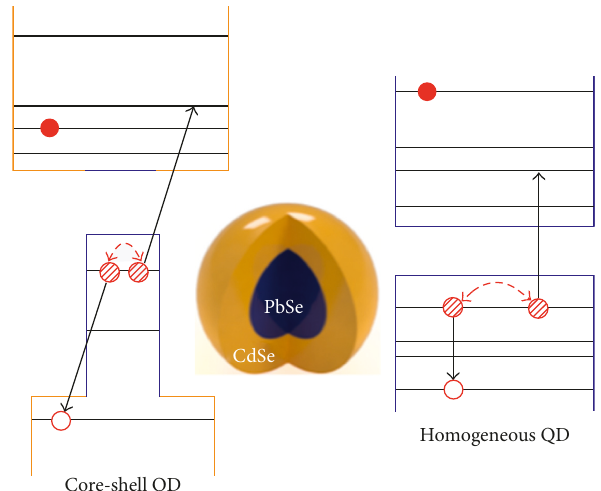
Figure 9: Graphic of the energy levels and states in core-shell QDs, adapted from [84].